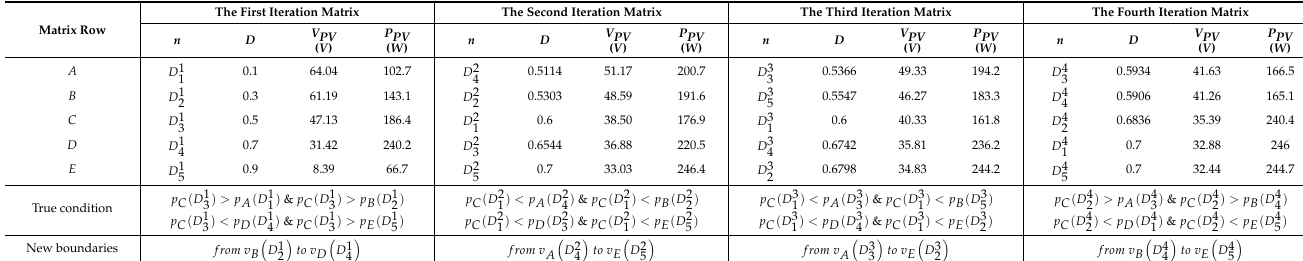
Figure 10. The GMPP tracking method for pattern-3. ( a ) The samples’ operating points at the first four iterations. ( b ) The tracking performance by using CSA. ( c ) The tracking performance by using ICSA. Table 7. The rearranged and saved data for pattern-3.